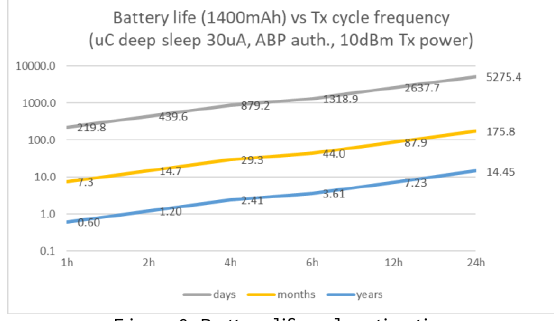
Figure 9. Battery lifecycle estimation